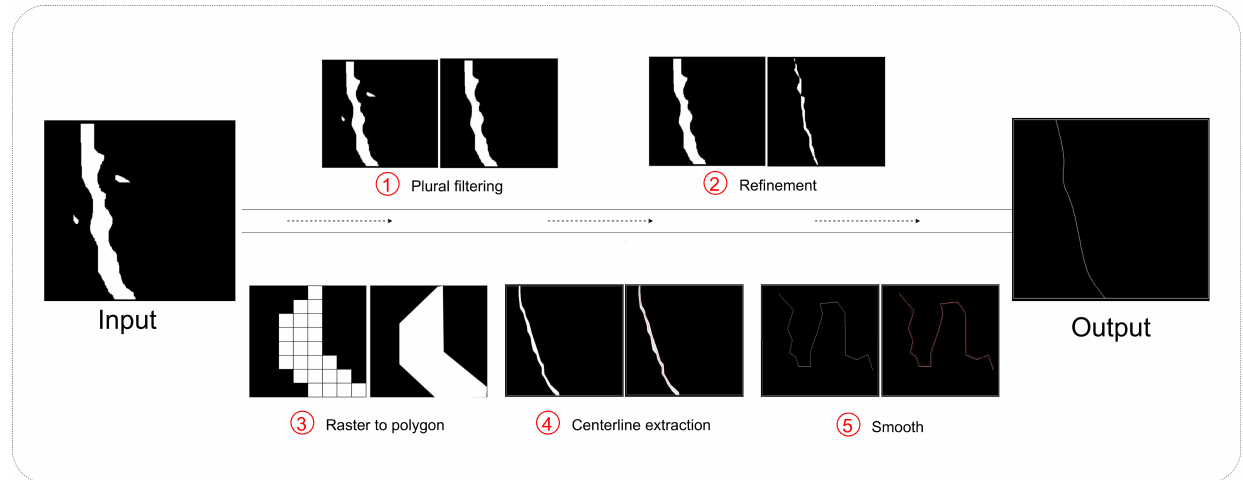
Figure 10. Post-processing of the CNN